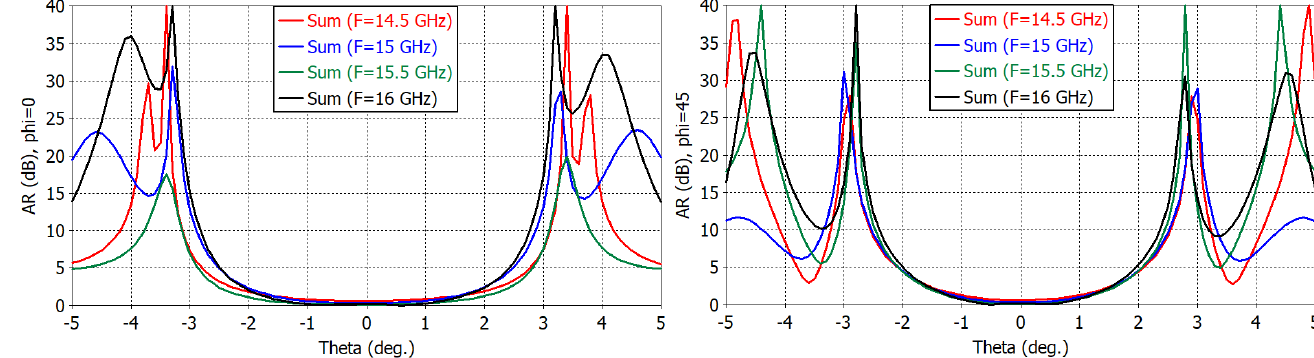
Figure 16. Sum channel axial ratio patterns of the reflector antenna.